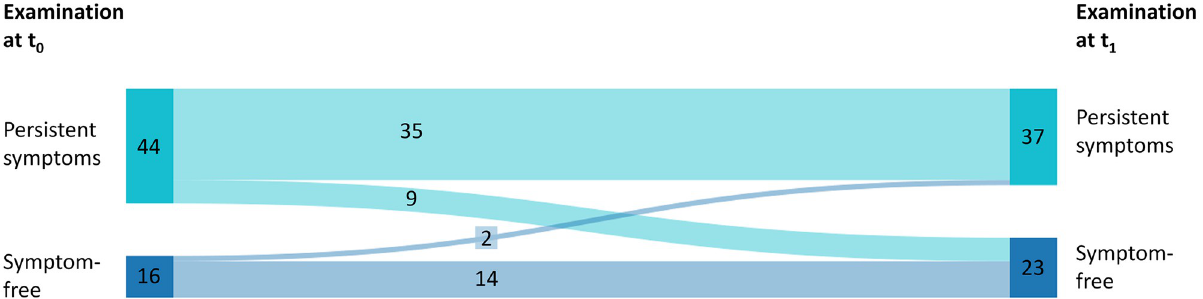
Fig 1. Development of symptom status. Symptom status of all 60 athletes at t 0 (first examination date) and t 1 (3.3 ± 0.5 months post first examination). 35 of 44 athletes, who had persistent symptoms at t 0 still stated persistent symptoms at t 1 (progression group PS-PS). Nine athletes became symptom- free over three months (progression group PS-SF). 14 of the 16 athletes remained symptom-free over the observation period (SF-SF). Two athletes developed symptoms over time. Data were collected with medical history and the International Consensus CFS questionnaire [24].